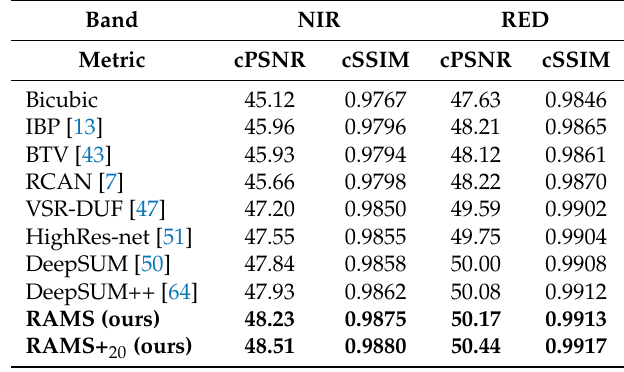
Table 1. Average cPSNR (dB) and cSSIM over the validation dataset for different methods. Our solution is highlighted in bold at the end of the table.